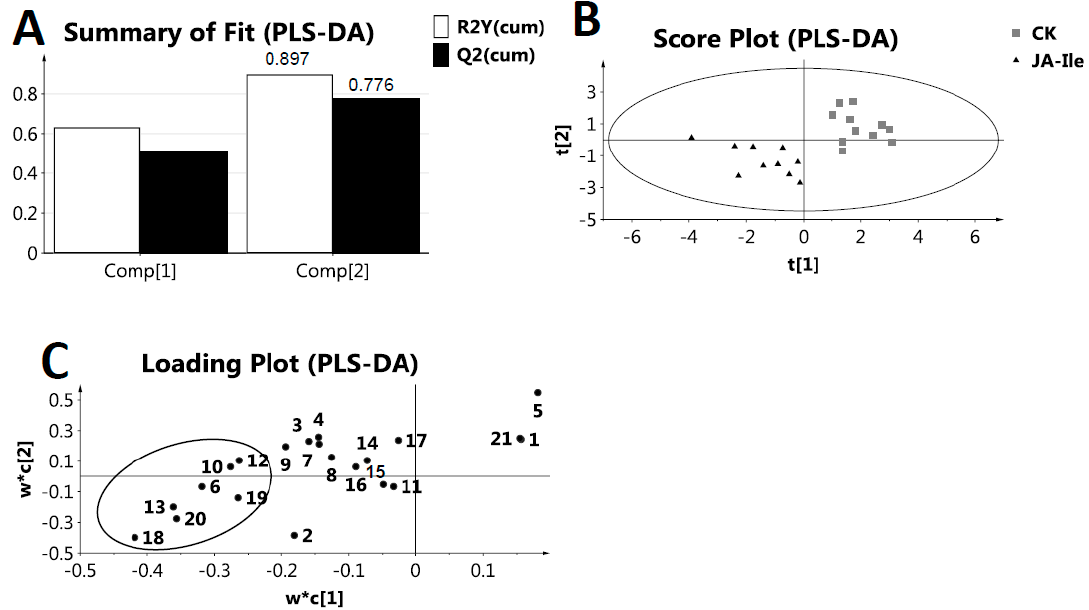
Figure 5. Partial least squares discriminant analysis (PLS-DA) of metabolites in L . leucocephala leaf extracts under JA-Ile elicitation. ( A ) The summary of fit of PLS-DA model of JA-Ile and control. The cumulative R2Y and Q2 were 0.897 and 0.776 respectively, when two components were calculated; ( B ) PLS-DA score plot discriminated L. leucocephala extracts from JA-Ile (triangle) and control treatment (CK, box) more clearly than PCA score plot; ( C ) PLS-DA loading plot. The notations of 1-21 were corresponding to different metabolites as listed in table 1. JA-Ile caused an accumulation of lactic acid ( 6 ), β -glucose ( 10 ), alanine ( 12 ), threonine ( 13 ), steroids ( 18 ), 3,4-dihydroxypyridine ( 19 ) and an unidentified compound 20 .